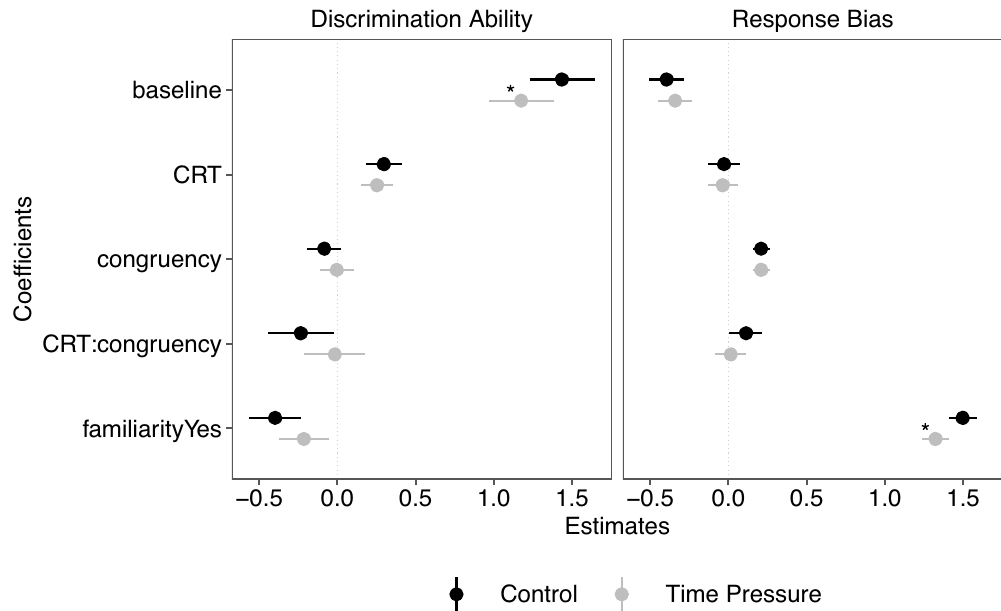
Figure 3. Visualisation of regression coefficients for the control treatment (in black) and the time-pressure treatment (in grey). All results derive from a single SDT analysis using participants’ responses (false news or true news) as the response variable but are shown in two panels to ease interpretation. The left panel shows all estimates for discrimination ability, with more positive (negative) values indicating higher (lower) discrimination ability. The right panel shows all estimates for response bias, with more positive (negative) values indicating a higher (lower) likelihood to judge headlines as true (false). Baseline: Overall estimate of discrimination ability (left panel) and response bias (right panel). CRT = Cognitive Reflection Test. Congruency = ideological congruency. Dots represent the mean; error bars represent the 95% CI of the posterior distribution. Credibly different effects between the control and time pressure treatments are marked with an asterisk (“*”). Note that all effects were mean centered except treatment (reference: control) and familiarity (reference: unfamiliar